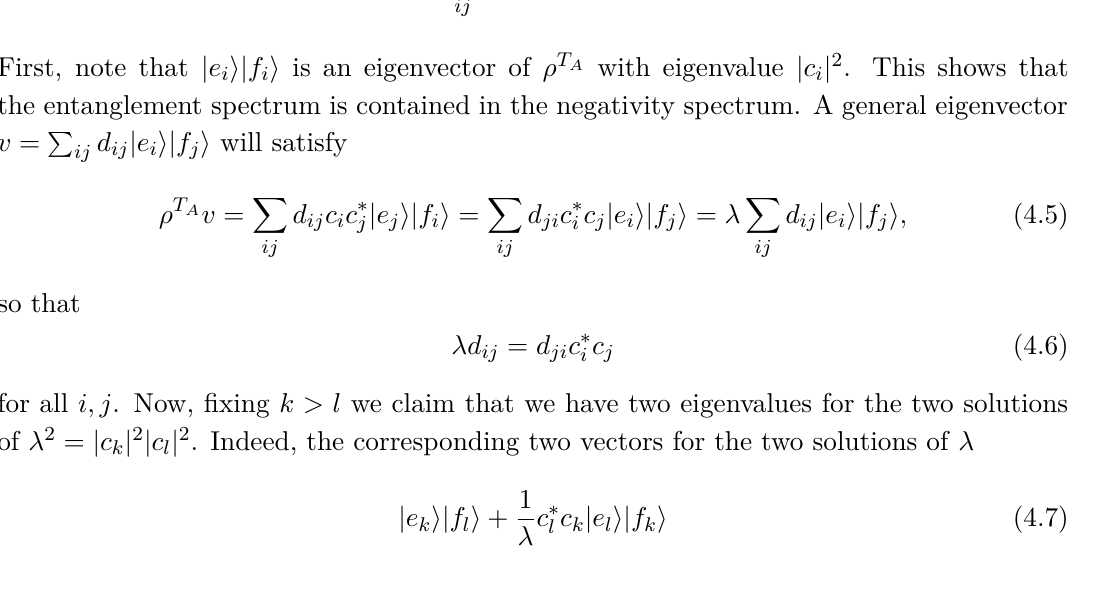
Figure 10 . The negativity spectrum for the two-tensor network as we vary w E = w = 3 , and N = 2 . There is the transition from vanishing negativity (Phase I w B = 6 , w C C 2 1 in the one-tensor network) between Phase 5 (upper left) to Phase 3 to Phase 4 (lower right) where the eigenvalues gain support on the negative real axis. The colors of the plots match the colors of the phases in figure 8. We average over 10 3